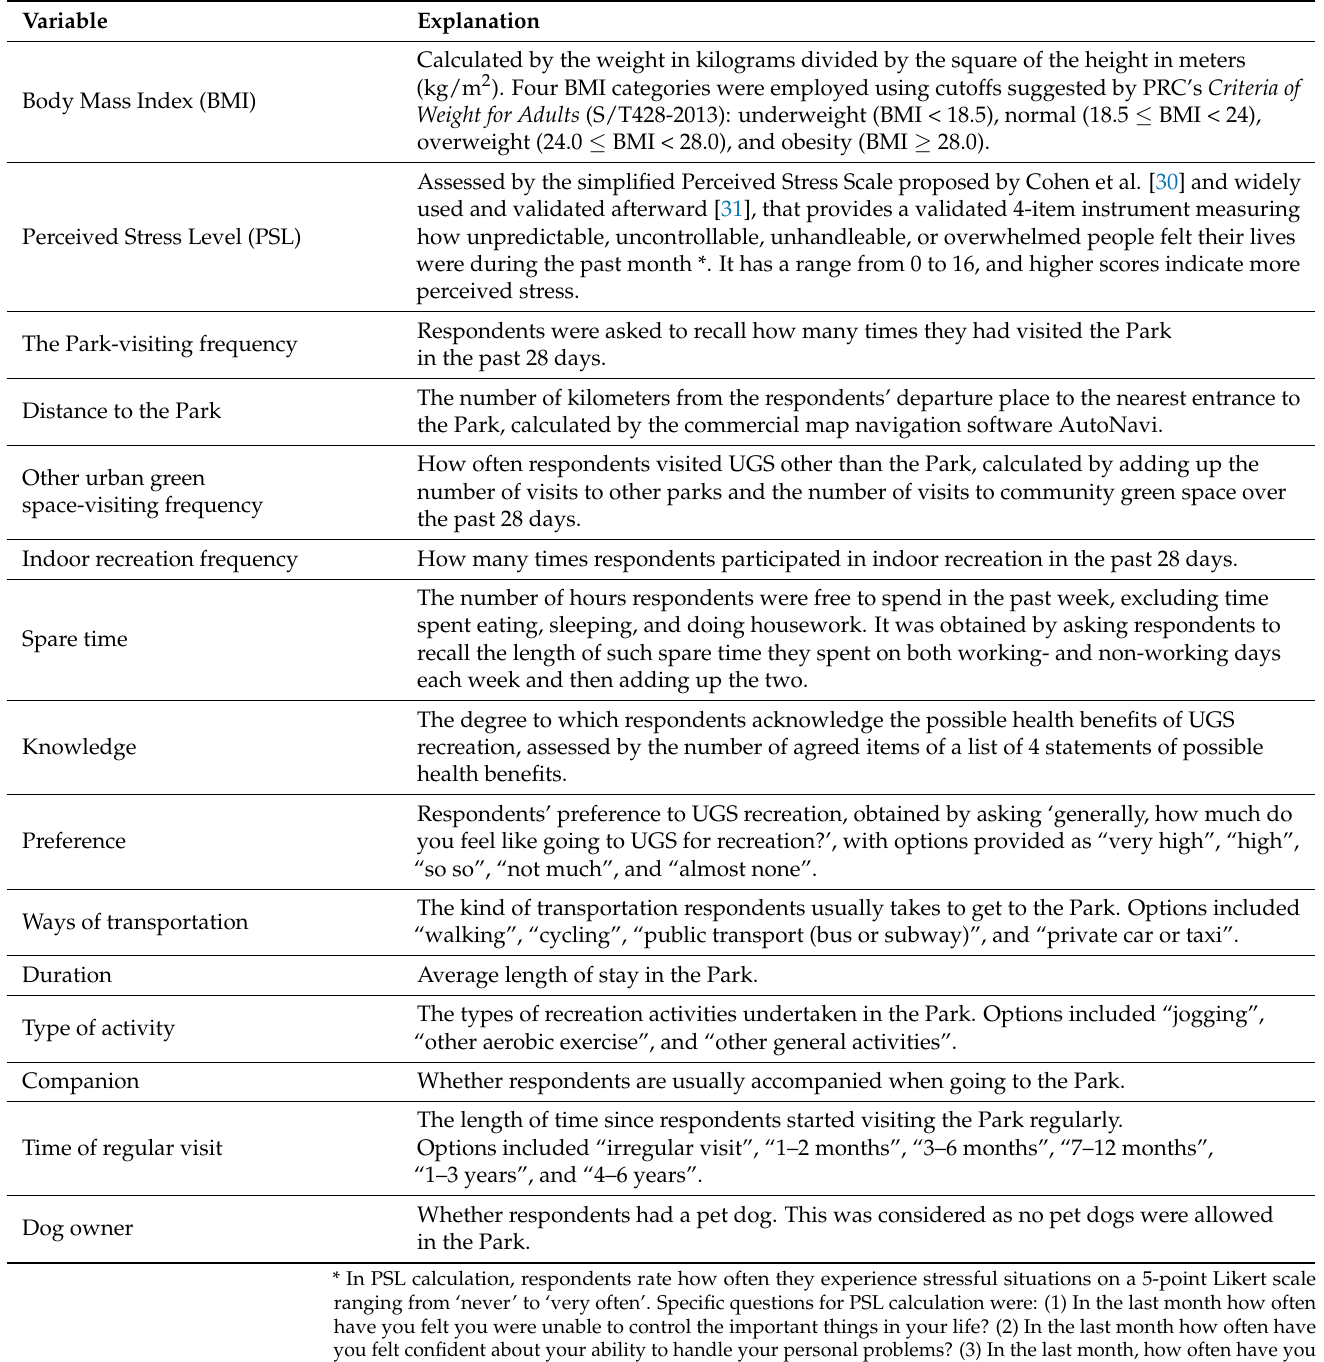
Table 1. Definition of